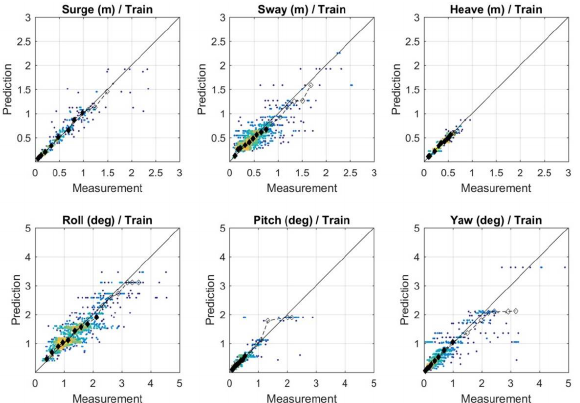
Figure 4. Scatter plots of comparison between the semi-supervised ML-based model predictions and measured data for the six DoF. Joint probability density represented by the color scale. Quantile values equally spaced between 1% and 99.999%, in Gumbel probability paper (-ln(-ln(F)): where F is the non-exceedance probability), are represented by diamond symbols (color-filled symbols for values between 1% and 90%, and by non-filled symbols for values between 90% and 99.999%). Training phase.